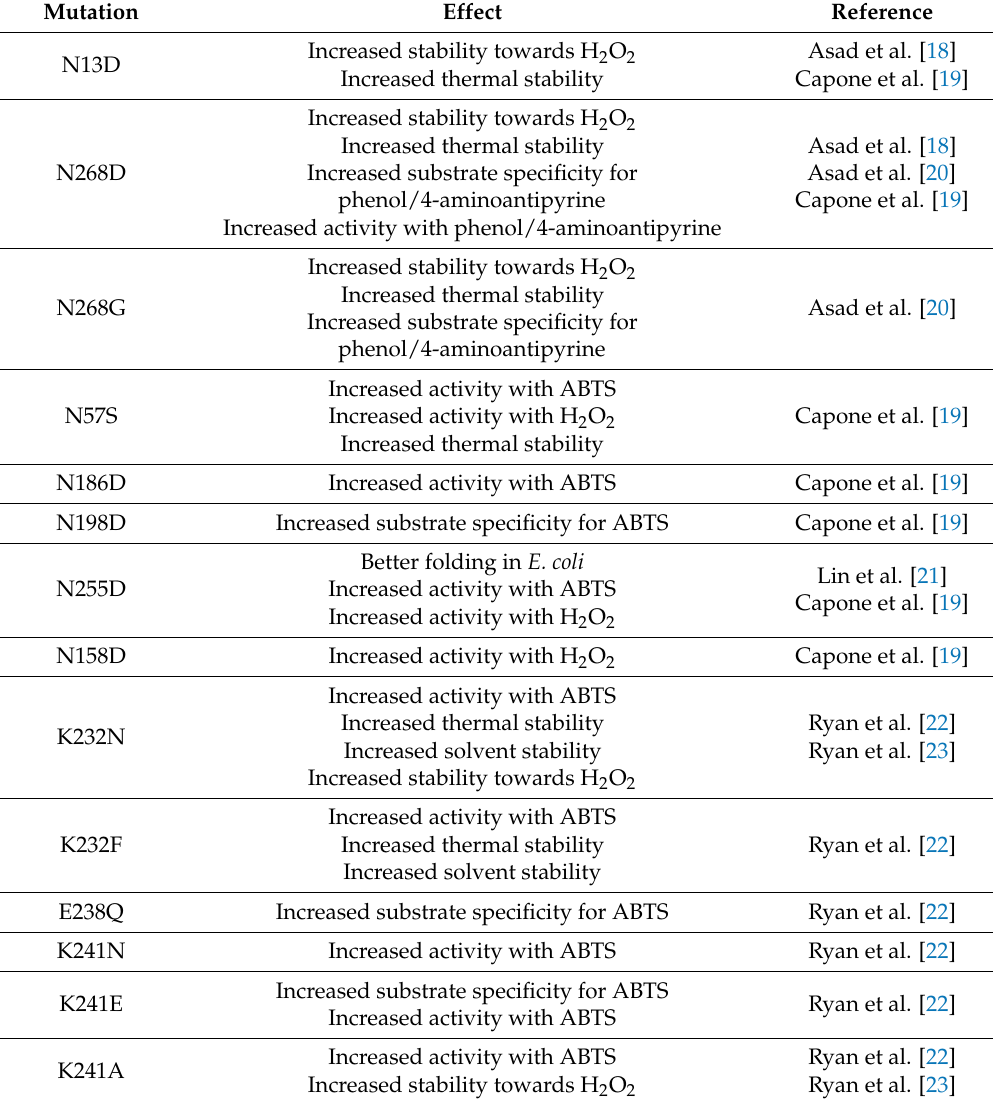
Table 1. List of rHRP mutations that improve enzyme performance, listed by